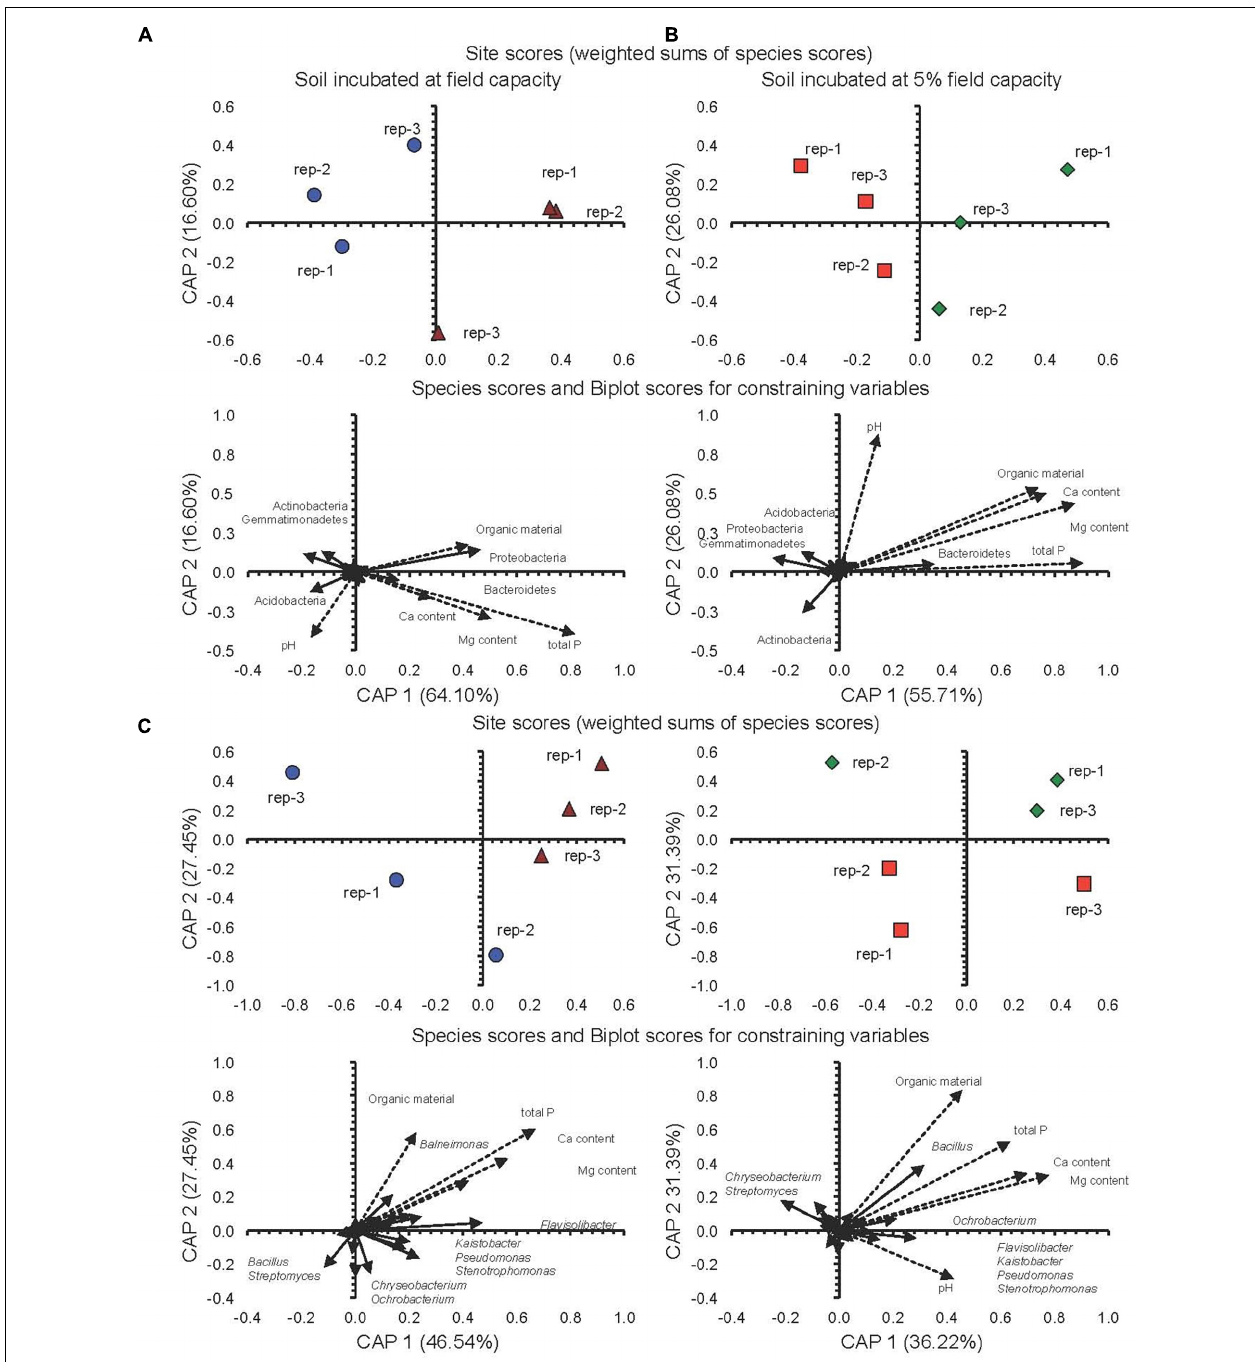
FIGURE 4 | (A) Canonical analysis of principal coordinates (CAP) with the different bacterial phyla and characteristics of conventional cultivated soil incubated at field capacity (FC) ( ) or milpa soil incubated at FC ( ), (B) conventional cultivated soil ( ) or the milpa soil ( ) incubated aerobically at 5%FC for 45 days, (C) CAP with the different bacterial genera and characteristics of conventional cultivated soil incubated at field capacity (FC) ( ) or milpa soil incubated at FC ( ), (D) conventional cultivated soil ( ) or the milpa soil ( ) incubated aerobically at 5%FC for 45 days.